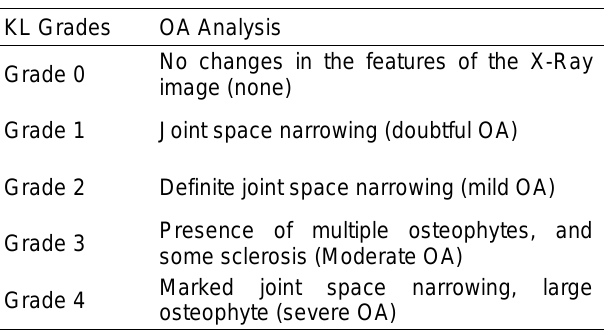
Figure 1. KL classification system for the evaluation of KOA severity [10] Table 1: KOA severity [11]